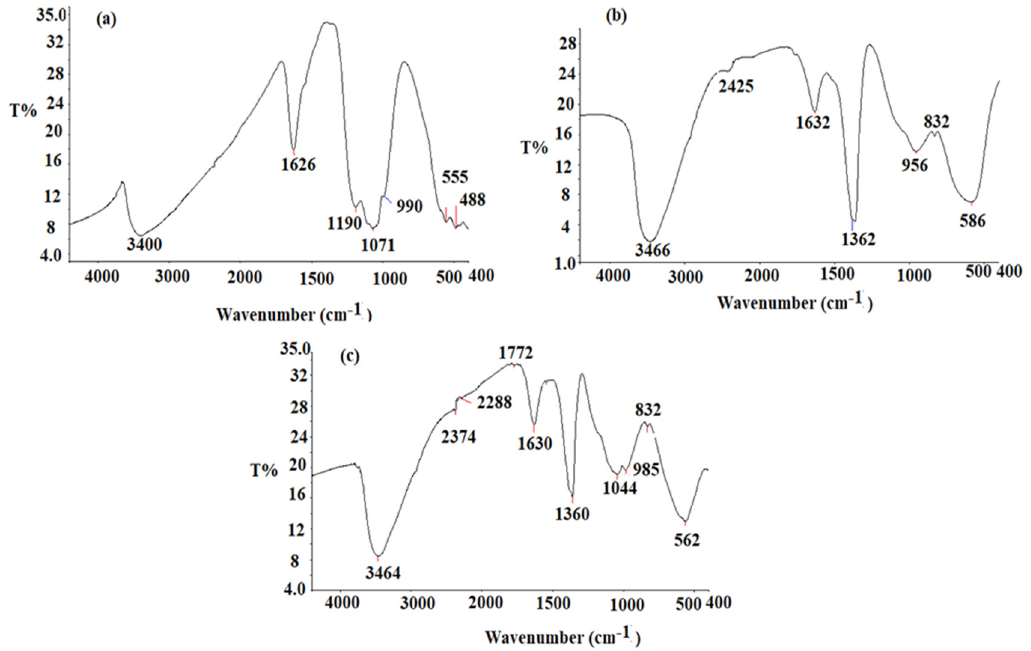
Figure 5. FT-IR spectrum of pre-synthesized ( a ) CeO 2 NPs, ( b ) Al 2 O 3 NPs, ( c ) CeO 2 /Al 2 O 3 nanocom- posite measured at wavenumber 400–4000 cm − 1 . The broad absorption bands, appeared at 3466 cm − 1 and 1632 cm − 1 , resulted from stretching and bending O-H vibration of absorbed water, respectively. The stretching vibra- tion of Al-OH bond appeared to correspond another band observed at 1362 cm − 1 . The peaks at 832 cm − 1 and 586 cm − 1 correspond to the Al-O bond [54]. The CeO 2 /Al 2 O 3 nanocompos- ite spectrum displayed various absorption bands at 3464 cm − 1 (O-H), 2374 cm − 1 (O=C=O of the carbon dioxide), and 1630 cm − 1 (O-H vibration mode of water). The